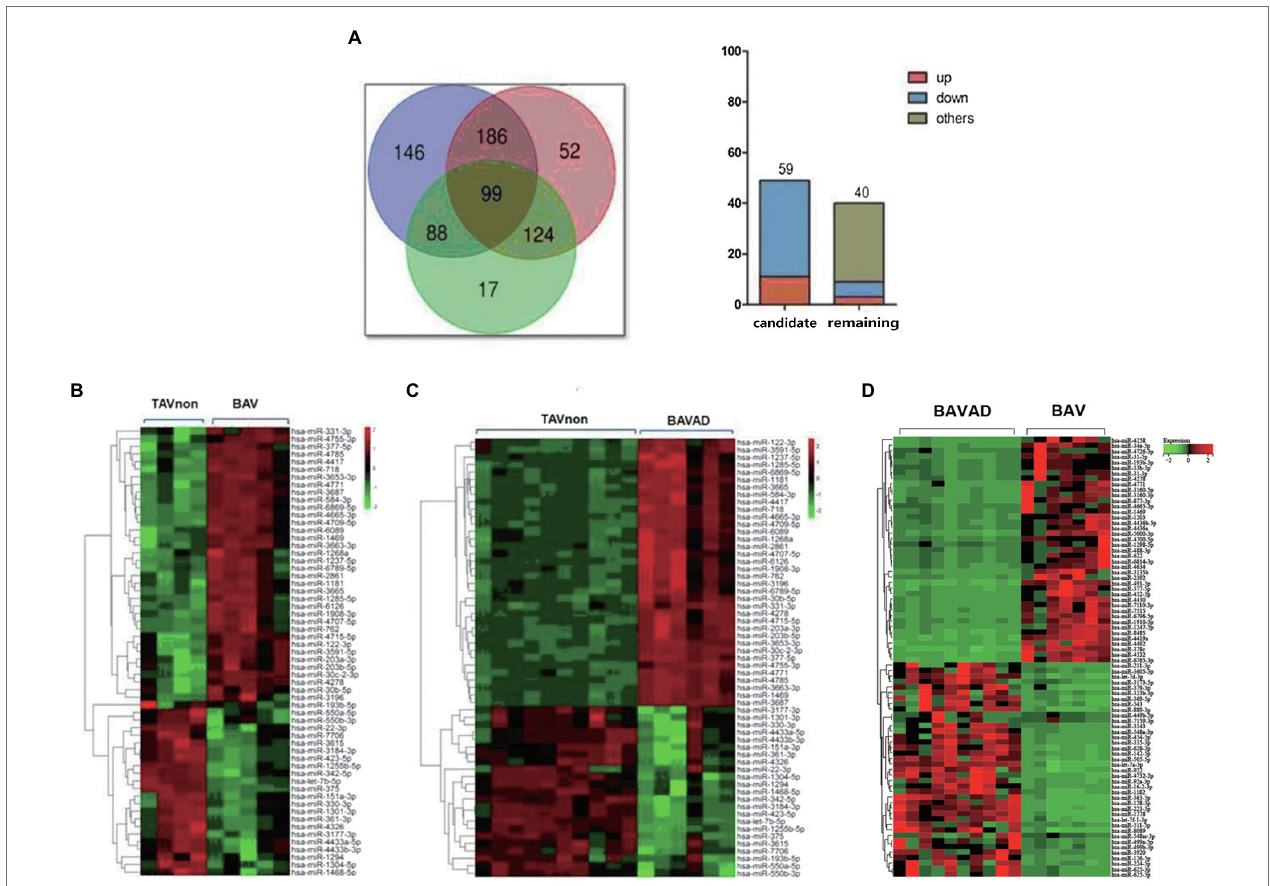
FIGURE 3 | Selection of candidate DE miRNAs. (A) Venn diagrams illustrating DE miRNAs between BAVAD vs. BAV (purple), BAVAD vs. TAVnon (red), or BAV vs. TAVnon (green) groups. The upward or downward trend distribution of DE miRNAs among these groups was shown. (B–D) Heat map illustrating 59 DE miRNAs between BAV vs. TAVnon group (B) , BAVAD vs. TAVnon group (C) , and BAV vs. BAVAD group (D) . Rows represent miRNAs, while columns represent patients or health individual